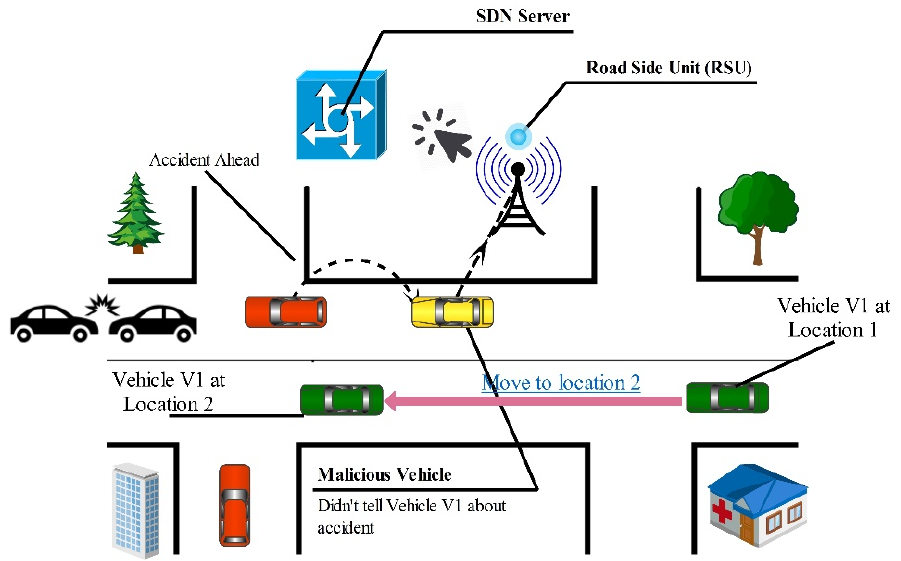
Figure 21. Timing attack in SDN-based VANETs.